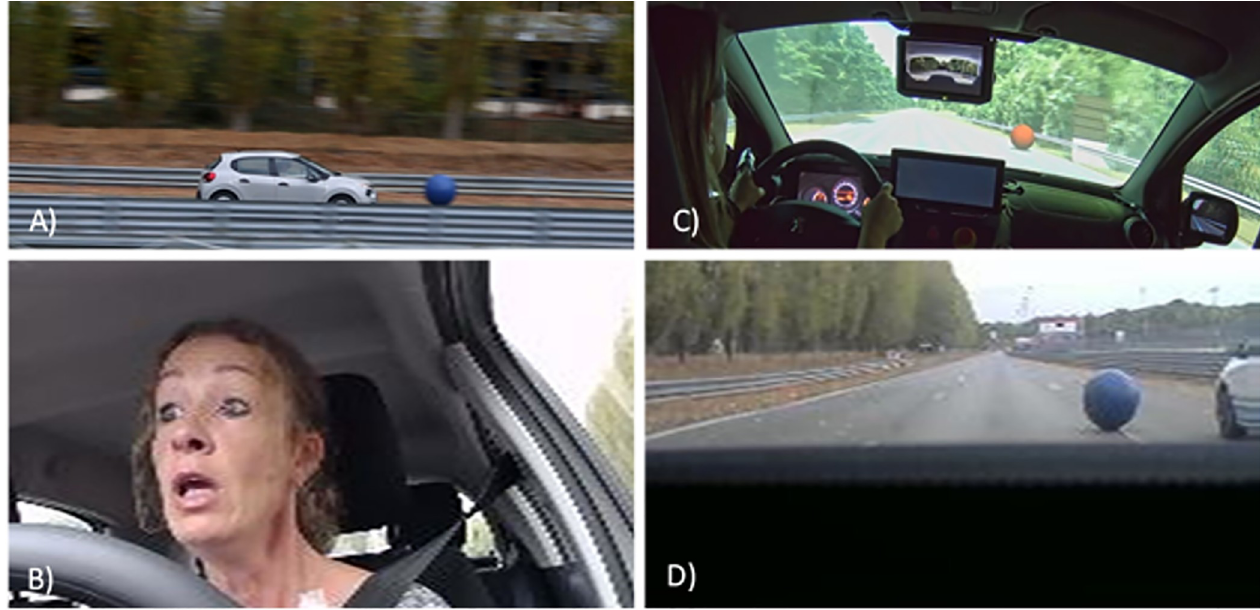
Fig 2. Protocol images. A) The car on the circuit with the ball crossing its path. B) The facial reaction of a driver discovering the ball crossing the road. C) A driver in the simulator with the ball beginning to cross the vehicle’s path. D) A view of the ball crossing the road as seen from inside the real car.